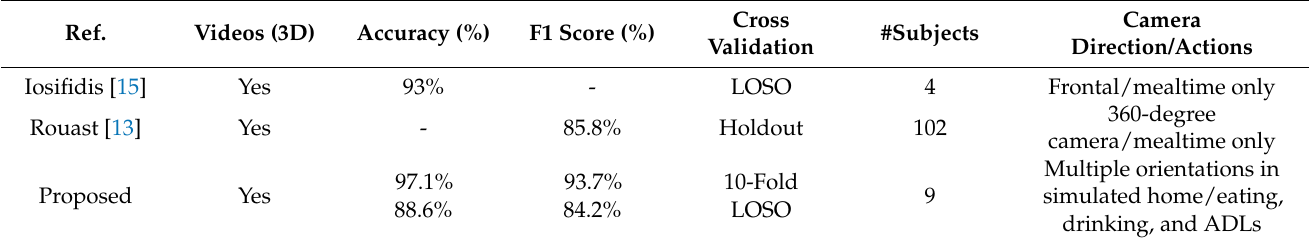
Table 3. Comparison with the